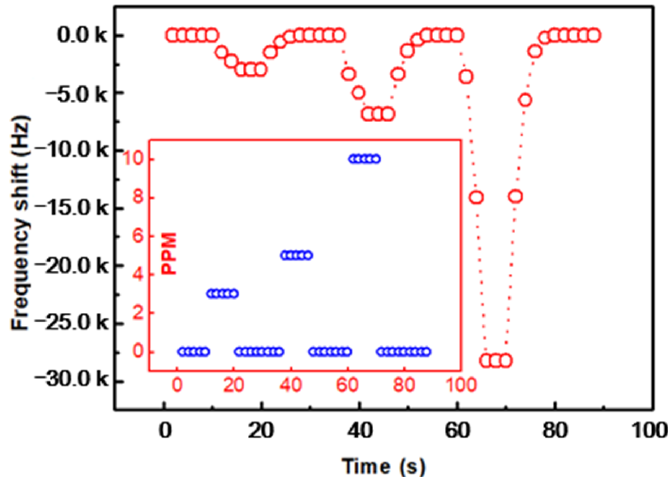
Figure 9. Dynamic response of the graphene/PVDF SAW sensor for DMMP.